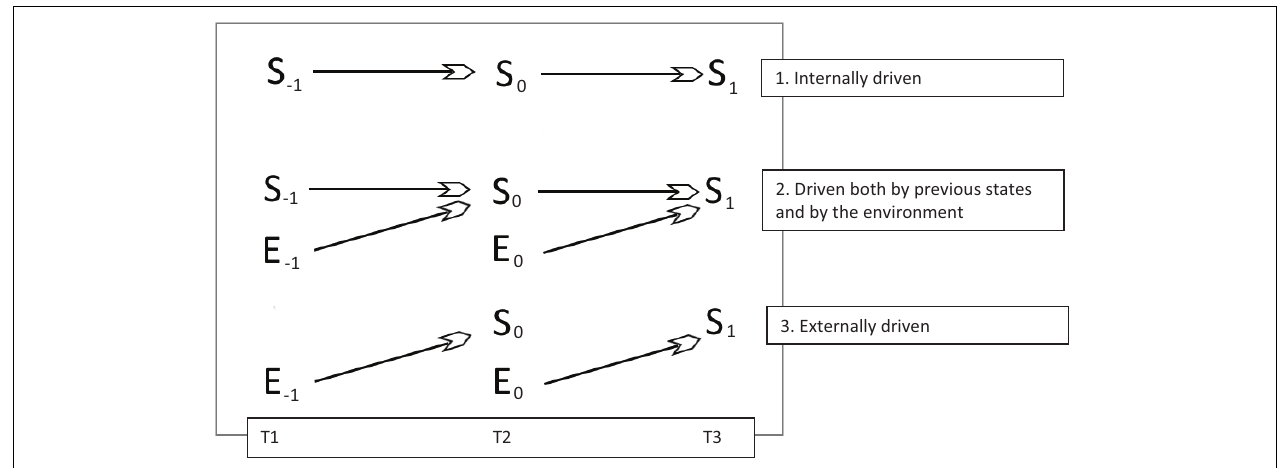
FIGURE 1 | Consciousness emerges in systems as a function of the degree in which futures states are determined by past states. Such a system can be said to be internally or endogenously driven. In flow chart 1, the system (S) best predicts its own future states. By looking at the system at time 0, we can predict what the system will be at time 1, or just the same what it was at time –1. This can allude to cases where the Default Mode Network (DMN) is active, and the mind is turned inward rather than being influenced by the senses. In flow-chart 2, the system is driven both by itself and by the environment (E). The flow of consciousness selectively integrates information from the environment. In flow-chart 3, the system is low in consciousness, and its behavior is entirely by the environment, or can be said to be externally driven. There is no continuous flow of internal information